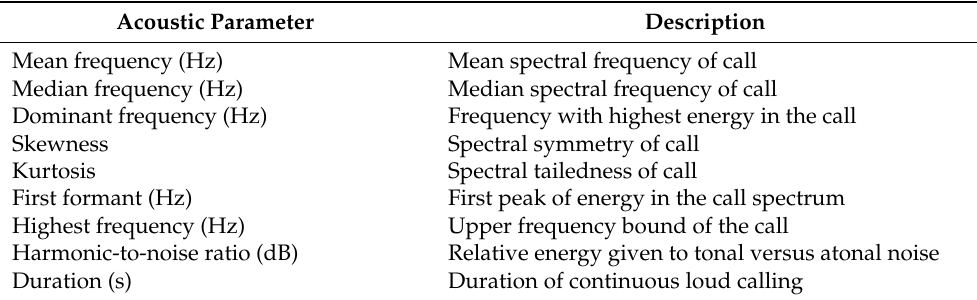
Table 3. Acoustic parameters measured from 102 howling bouts of Guianan red howler monkeys at the Viru á National Park, Roraima,